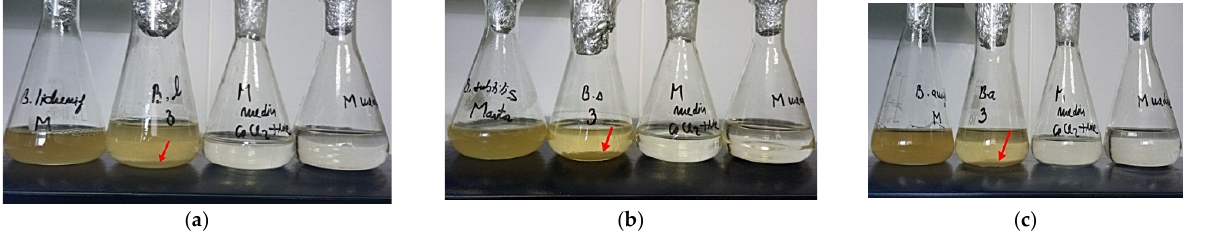
Figure 4. Images of experiments performed with Bacillus strains in medium with or without urea and Ca 2+ : ( a ) B. licheniformis; ( b ) B. subtilis; ( c ) B. amyloliquefaciens. In order from left to right, bacterial culture on TSB medium; bacterial culture on medium with urea and Ca 2+ ; M medium , control, as medium mineral with urea and Ca 2+ , non ‐ inoculated; M medium , control as medium mineral without urea and Ca 2+ , non ‐ inoculated; red arrow—white deposit containing bacterial biomass and calcium carbonate.